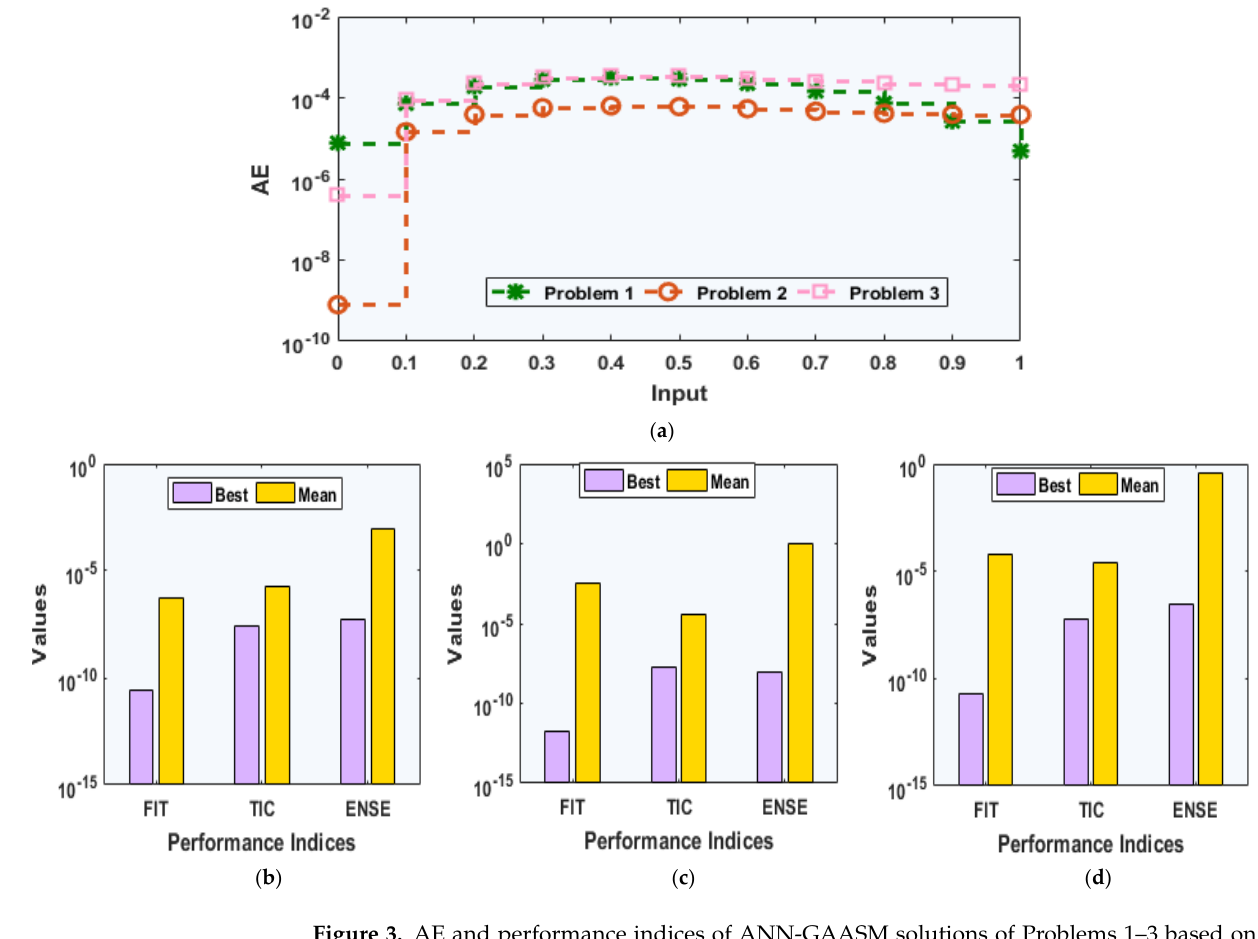
Figure 3. AE and performance indices of ANN-GAASM solutions of Problems 1–3 based on the second kind of NLE-PDSM. ( a ) AE values for Problems 1–3. ( b ) Performance indices for Problem 1. ( c ) Performance indices for Problem 2. ( d ) Performance indices for Problem 3. Table 2. Statistical performances of ANN-GAASM solutions of Problems 1–3 based on the second kind of NLE-PDSM .